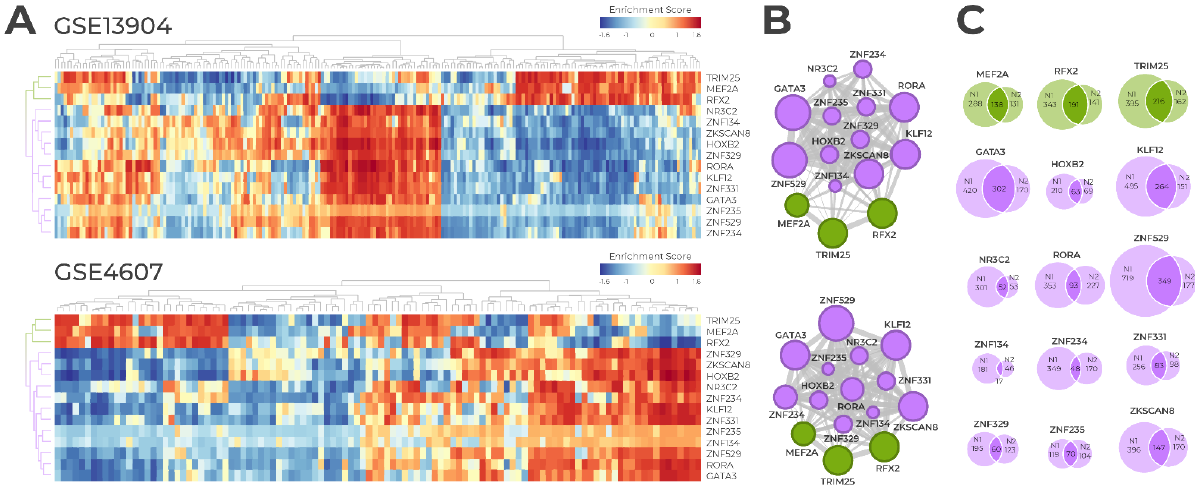
Figure 4. ( A ) Heatmaps showing the regulatory activity of the 15 master regulators in both the Pediatric Sepsis 1 cohort (GSE13904) and Pediatric Sepsis 2 cohort (GSE4607). Y-axis shows the 15 regulons and X-axis shows all samples in each dataset (99 and 108 septic samples in the datasets GSE13904 and GSE4607, respectively). The color code indicates regulon activity, being red when a regulon is activated in a given sample and blue when a regulon is inhibited in a given sample. ( B ) Association map network, showing the connection between the regulons. Nodes represent regulons, and the node widths are proportional to the number of mutual target genes between each two transcription factors. ( C ) Venn diagrams showing the number of genes in each of the 15 regulons, and the regulon similarity comparing Pediatric Sepsis 1 and 2 datasets.